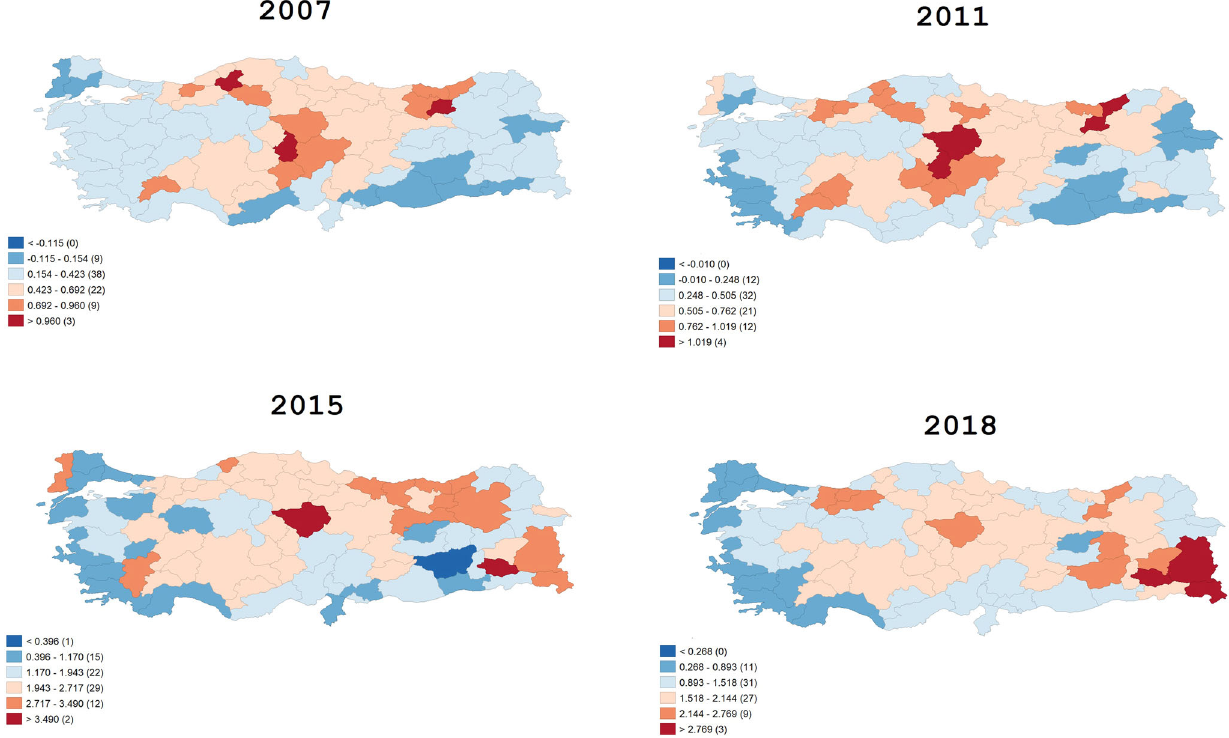
Fig. 2 Standard deviation map of attendance at the province level. Standard deviation map of the population share of attendance of Qur'an courses. Reddish colors represent more intense